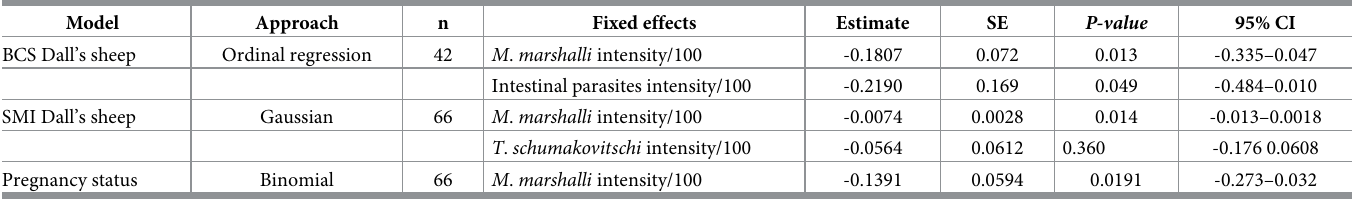
Table 3. Final Generalized Linear Models for BCS, SMI and pregnancy status of adult female Dall’s sheep from Mackenzie Mountains.